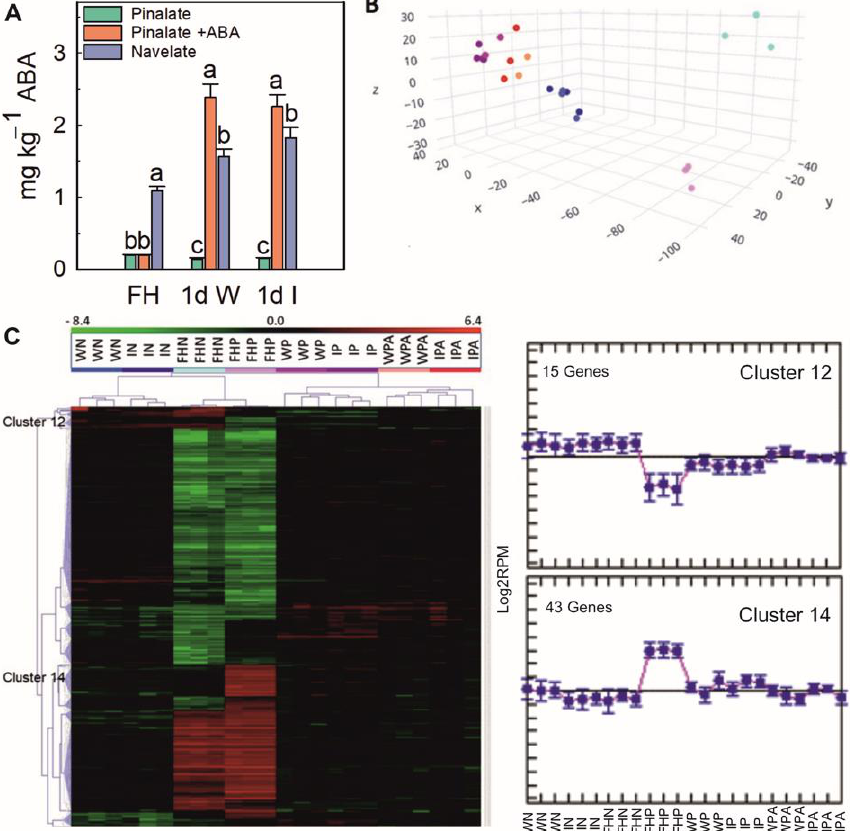
Figure 2. ABA content in both the freshlyharvested (FH) fruit and wounded (1d W) and infected (1d I) samples taken at 1 dpi. Different letters mean significant differences ( p ≤ 0.05) between Navelate fruit and its mutant Pinalate, treated or not with ABA, for the same storage period. ( A ) The Principal Component Analysis (PCA) ( B ) and the heatmap of the hierarchical cluster analysis (HCA) ( C ) of the expressed genes according to the RNA-Seq analysis. The DEGs meeting a cutoff of STEDV > 0.6 and |Log 2 FoldChange| ≥ 1 were considered in the HCA for all the conditions. The colors used in the PCA for each sample are the same as those employed for the same samples on the heatmap. FHN: freshly-harvested Navelate; WN: wounded Navelate at 1 dpi; IN: infected Navelate at 1 dpi; FHP: freshly-harvested Pinalate; WP: wounded Pinalate at 1 dpi; IP: infected Pinalate at 1 dpi; WPA: wounded Pinalate treated with ABA at 1 dpi; IPA: infected Pinalate treated with ABA at 1 dpi. The colors on the heatmap represent the median centered Log 2 (RPM) expression values for each condition and change from dark red (induction) to light green (repression). Clusters 12 and 14 are highlighted in Figure 1C. The samples on the X -axis follow the same order as on the heatmap. Three biological replicates from each condition were used for all the analyses. The error interval indicates the standard error of the estimated mean